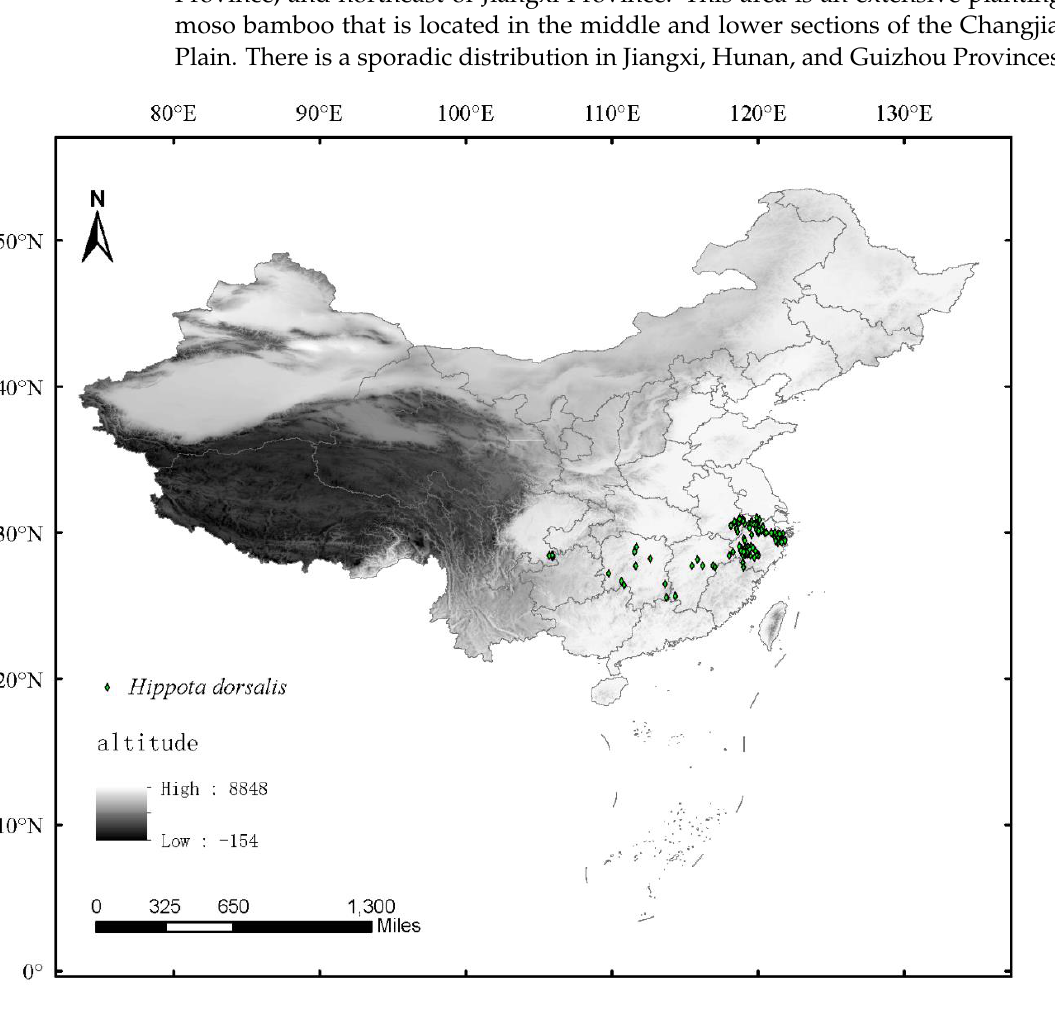
Figure 4. Occurrence records of Hippotiscus dorsalis in China.